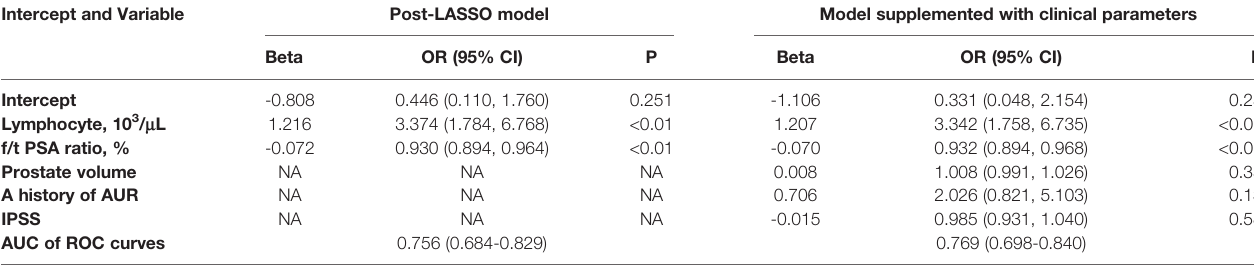
TABLE 3 | Risk factors for prostatic in fl ammation in patients with LUTS/BPH. Intercept and Variable Post-LASSO model Model supplemented with clinical